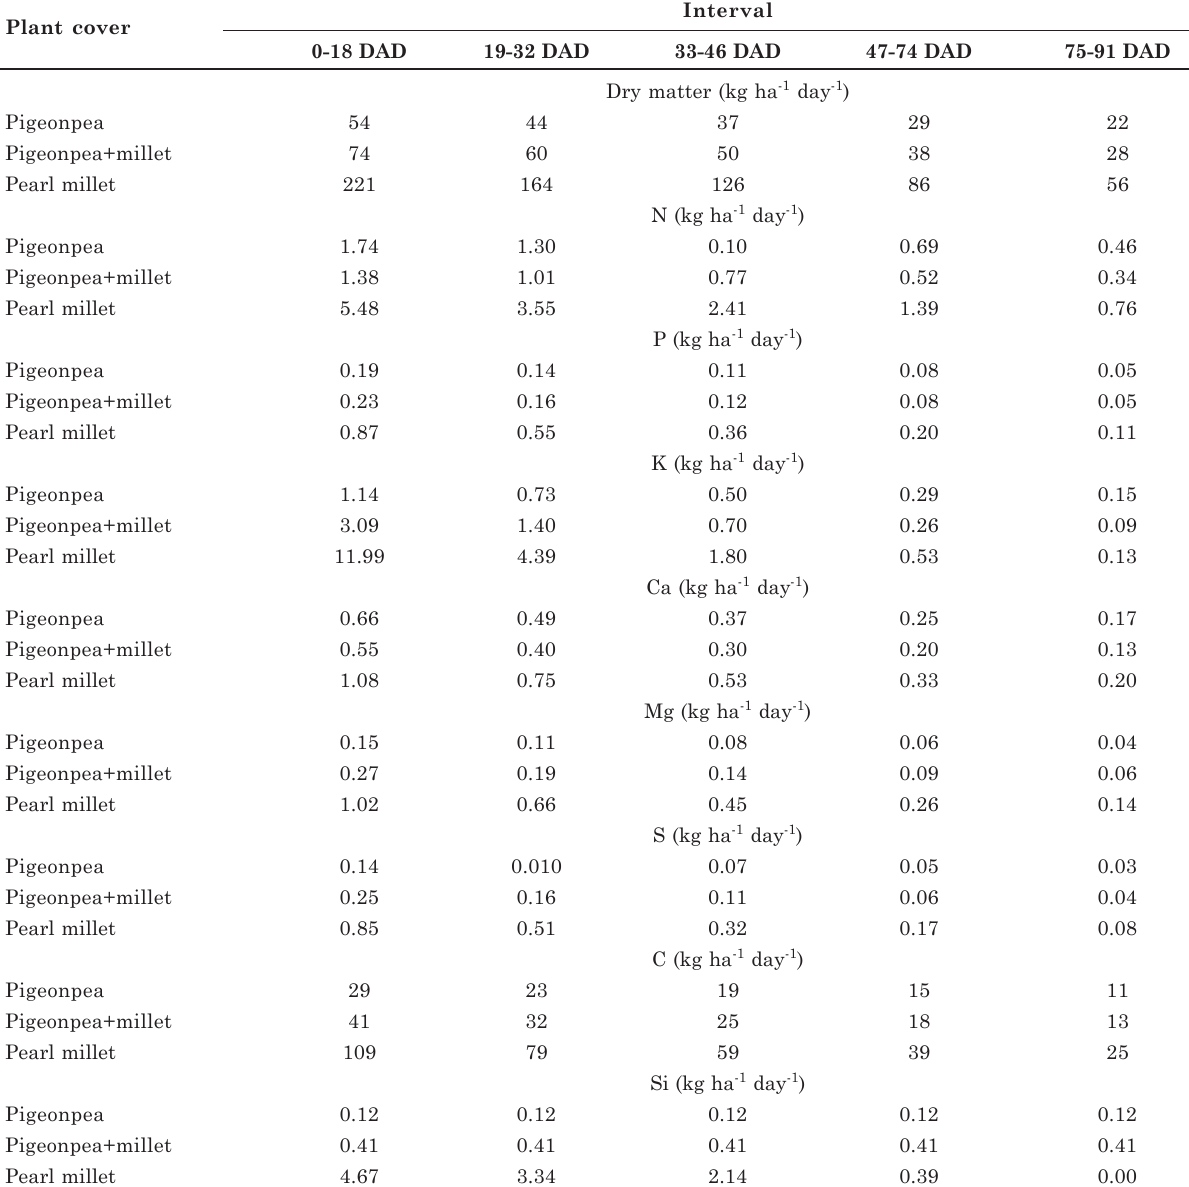
Table 2. Rates of decomposition and daily releases of N, P, K, Ca, Mg, S, C and Si of pigeonpea,